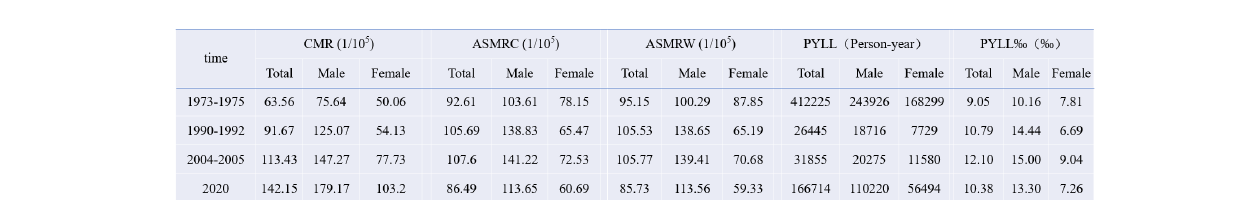
FIGURE 4 Mortality of cancers in Inner Mongolia, four times in the period of 1973 – 2020, Chi-square values of crude mortality between different sexes in the four period were 279.201, 346.055, 292.948, and 1,748.216, respectively; Chi-square values of ASMRC between different sexes were